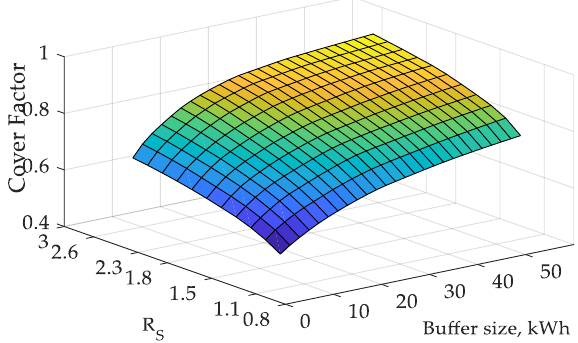
Figure 9. Influence of BB size and R S on cover factor.